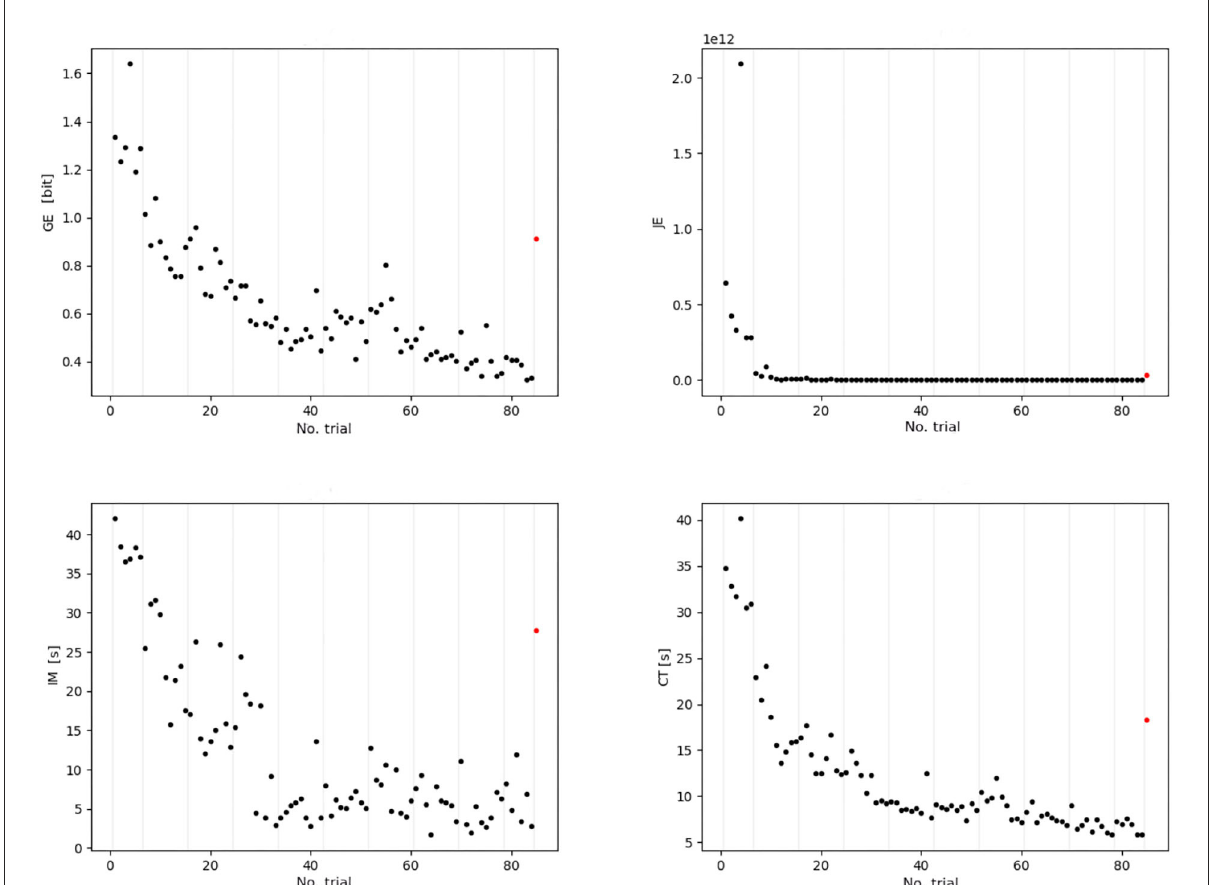
FIGURE3 Four metrics (GE, JE, IM, and CT) of one participant of the VP group (ordinate axis indicates raw value scale, i.e., the values prior to standardization). The black dots represent parts of the signal of each indicator that will be preprocessed to build the input features via exponential fitting, they correspond to the training routes. The red dot exhibits the target value to be predicted; these target values correspond to the last transfer route. The gray vertical lines indicate the session’s division. It is worth noting that the transfer route fluency score is of different nature than the practice session scores; thus, it cannot be estimated by extrapolating the exponential regression.